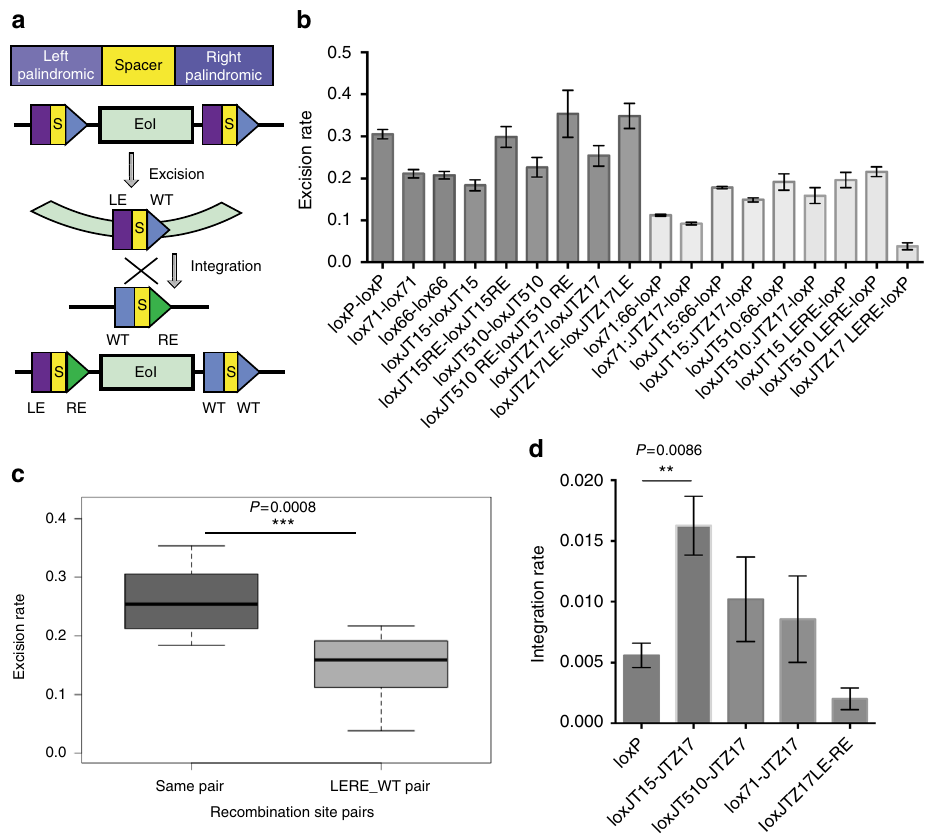
Fig. 2 Integration rate improvement by LE/RE strategy. a LE/RE strategy was used to improve the integration ef fi ciency. The functional domains of a recombination site are divided as a spacer region and two palindromic regions. The recombination between LE and RE mutation site generates a LE:RE double-mutant site and a wild-type loxP site. For in vitro application, a genetic Element of Interest (EoI) fl anked by two LE sites is fi rst excised out, and then integrates into an RE site, fi nally being fl anked by a LE/RE site and a loxP site. b Excision rate quanti fi cation of palindromic mutant site pairs (LE – LE or RE – RE) and double-mutant site and loxP site (LE:RE-loxP). LE includes lox71, loxJT15, loxJT510, loxJTZ17LE; RE includes lox66, loxJT15RE, loxJT510 RE, loxJTZ17. Error bar represents the standard deviation, n = 3. c Excision rate comparison between same pair recombination group and LE:RE – WT pair recombination group. Center value represents the mean of the excision rates. t test was performed for difference evaluation between the two groups. d Integration rate quanti fi cation of selected LE- and RE-mutant sites. The integration rate between loxJT15 and loxJTZ17 is three-fold of that between loxP site. Error bar represents the standard deviation and P value was generated by t test, n = 3. LE, left element with mutation in left palindromic region, RE, right element with mutation in right palindromic region